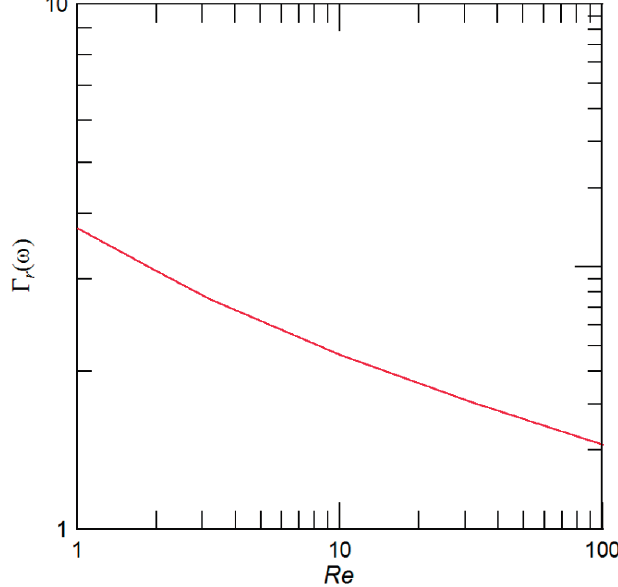
Figure 2. Dependency of the real part of hydrodynamic function, Γ r , on the Reynolds number, Re